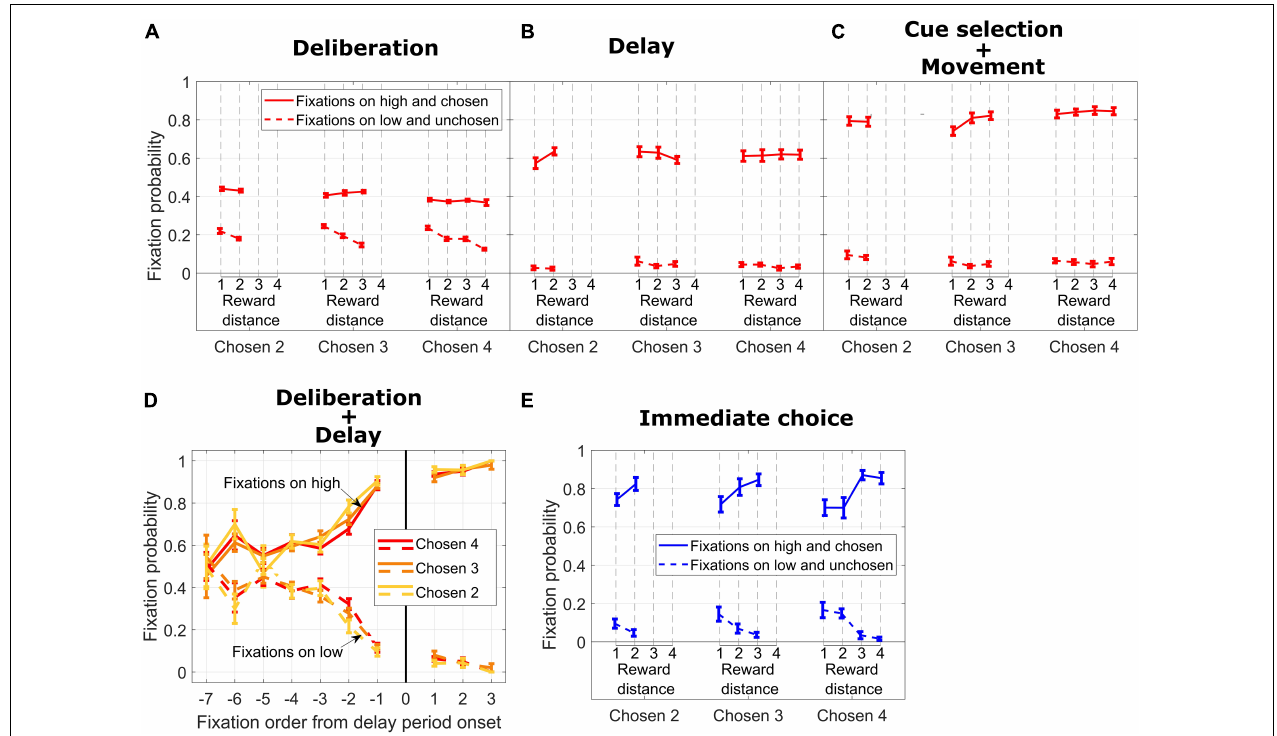
FIGURE 3 | (A) Fixation probability on high/chosen (solid lines) and low/unchosen (dotted lines) cues vs. reward distance (RD) for different Chosen Values during DC trials, during the deliberation period. (B) Same format as in (A) for the delay period. (C) Same format as in B for cue selection and movement period. (D) Fixation probability on high/chosen (solid lines) and low/unchosen (dotted lines) cues for different Chosen Values vs. fixation order from end of the deliberation period. (E) Same format as in (C) for IC